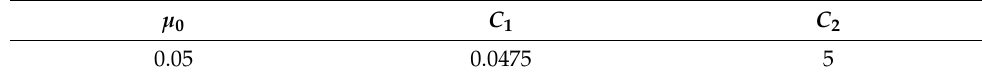
Table 4. The parameters of modified O-K model.